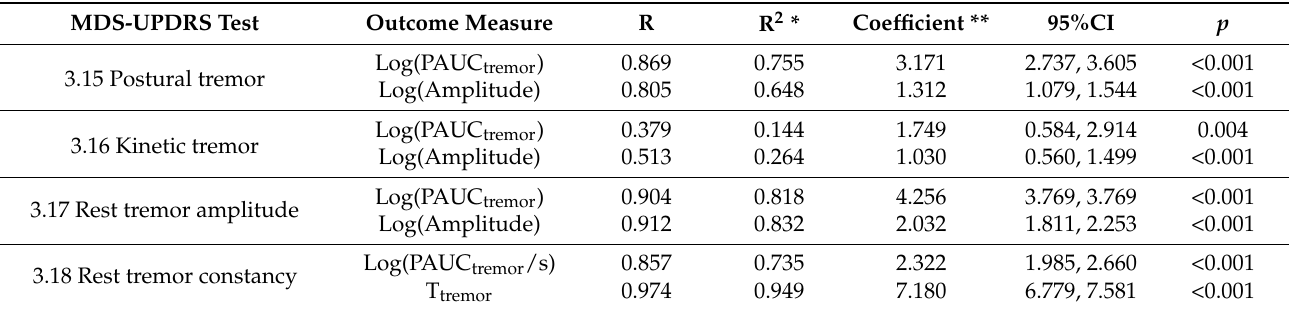
Table 2. Regression analysis